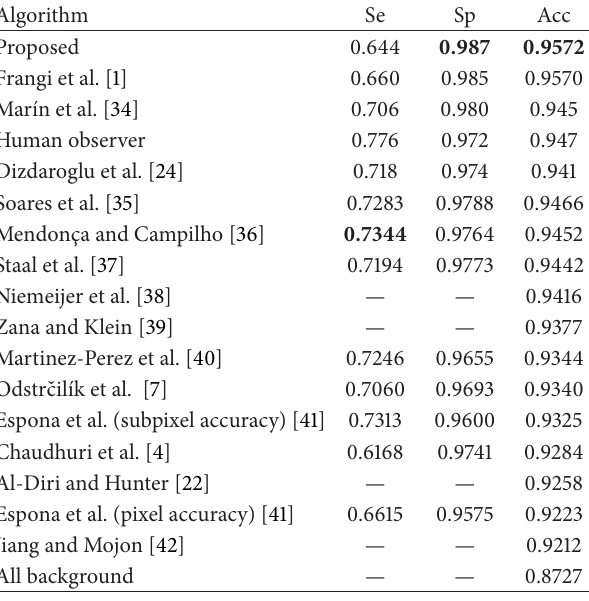
Table 1: Details of used databases. Table 2: Comparison of the results using the DRIVE [26] public database. The proposed methods achieved the best accuracy (Acc) compared to the state-of-the-art